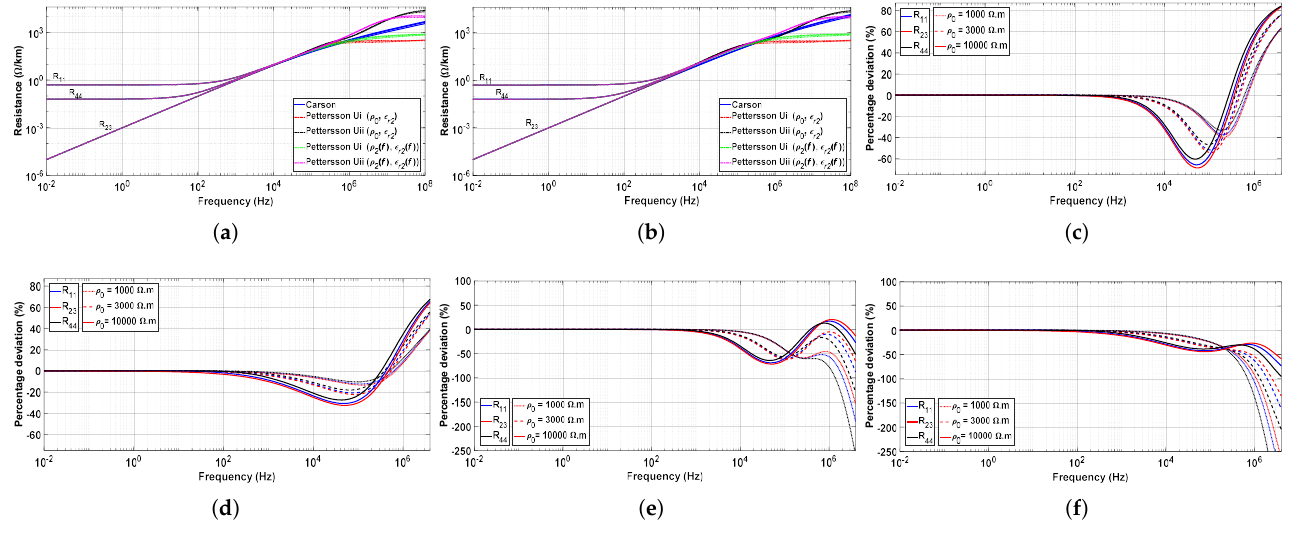
Figure 8. ( a ) Resistance ( Ω /km) for the 1000 Ω .m; ( b ) Resistance ( Ω /km) for the 10,000 Ω .m; ( c ) Percentage deviation between Carson’s and Pettersson’s formulation Ui; ( d ) Percentage deviation between Carson’s and Pettersson’s formulation Ui with frequency dependence; ( e ) Percentage deviation between Carson’s and Pettersson’s formulation Uii; ( f ) Percentage deviation between Carson’s and Pettersson’s formulation Uii with frequency dependence.